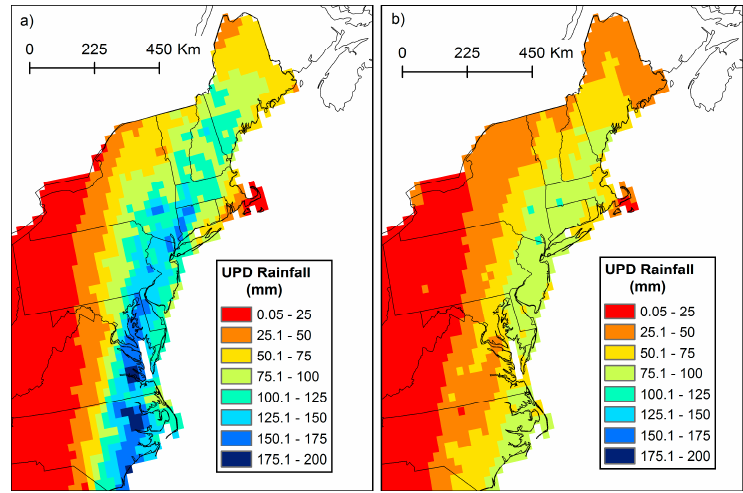
Figure 9. Mean rainfall produced by ( a ) four TCs with linkages to deep tropical moisture, and ( b ) seven TCs that do not source their moisture from the deep tropics.